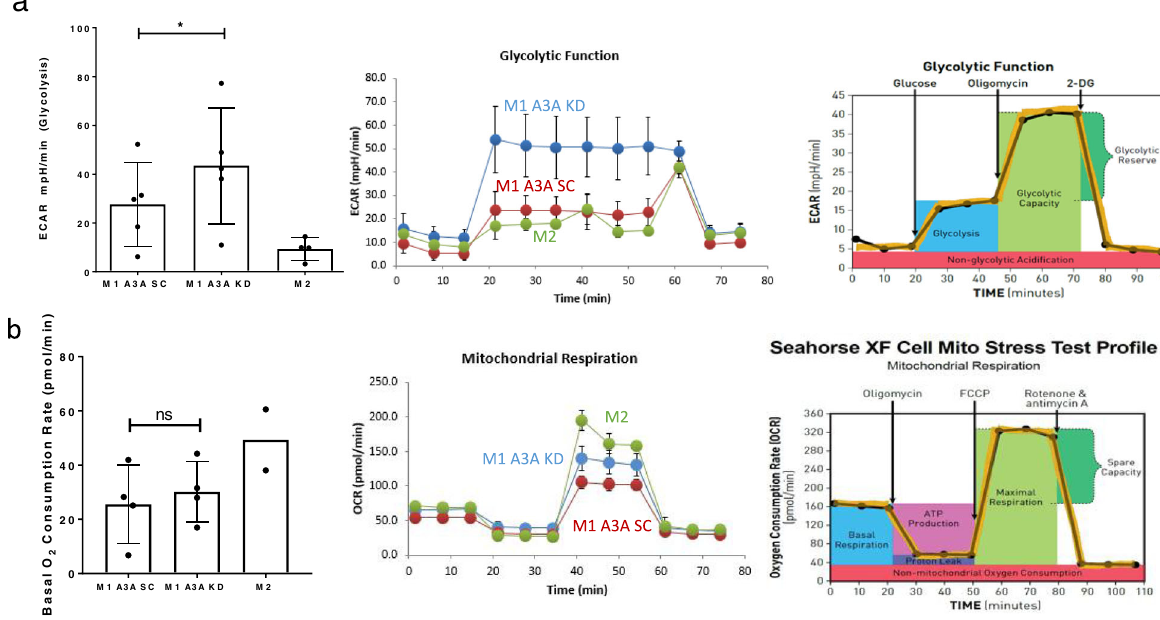
Fig. 7 The role of A3A in glycolysis and oxygen consumption in macrophages. a A3A KD enhances glycolysis (ECAR) compared to A3A SC M1 macrophages derived from normal donor blood. P = 0.0171, Paired t test of glycolysis values, two-tailed, fi ve donors. A representative original trace from SeaHorse platform shows ECAR in M1 A3A KD cells relative to control M1 A3A SC. b Basal oxygen consumption rate is similar between M1 A3A KD and M1 A3A SC macrophages. P not signi fi cant ( P = 0.1358), Paired t test of basal oxygen consumption values, two-tailed, four donors. A representative original trace from SeaHorse platform shows basal oxygen consumption in M1 A3A KD cells relative to control M1 A3A SC. M2 macrophage data from a smaller number of donors ( n = 2, 4) are shown for comparison. Data in scatter dot plots with mean ±